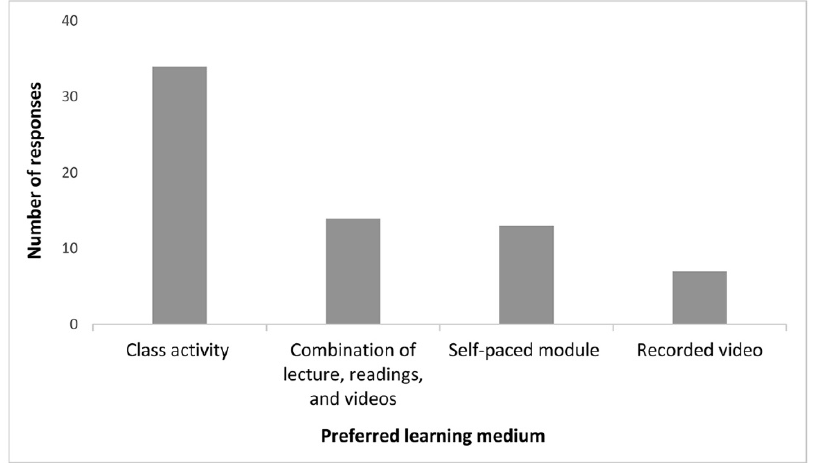
Figure 2 Students’ preferred learning media for information literacy